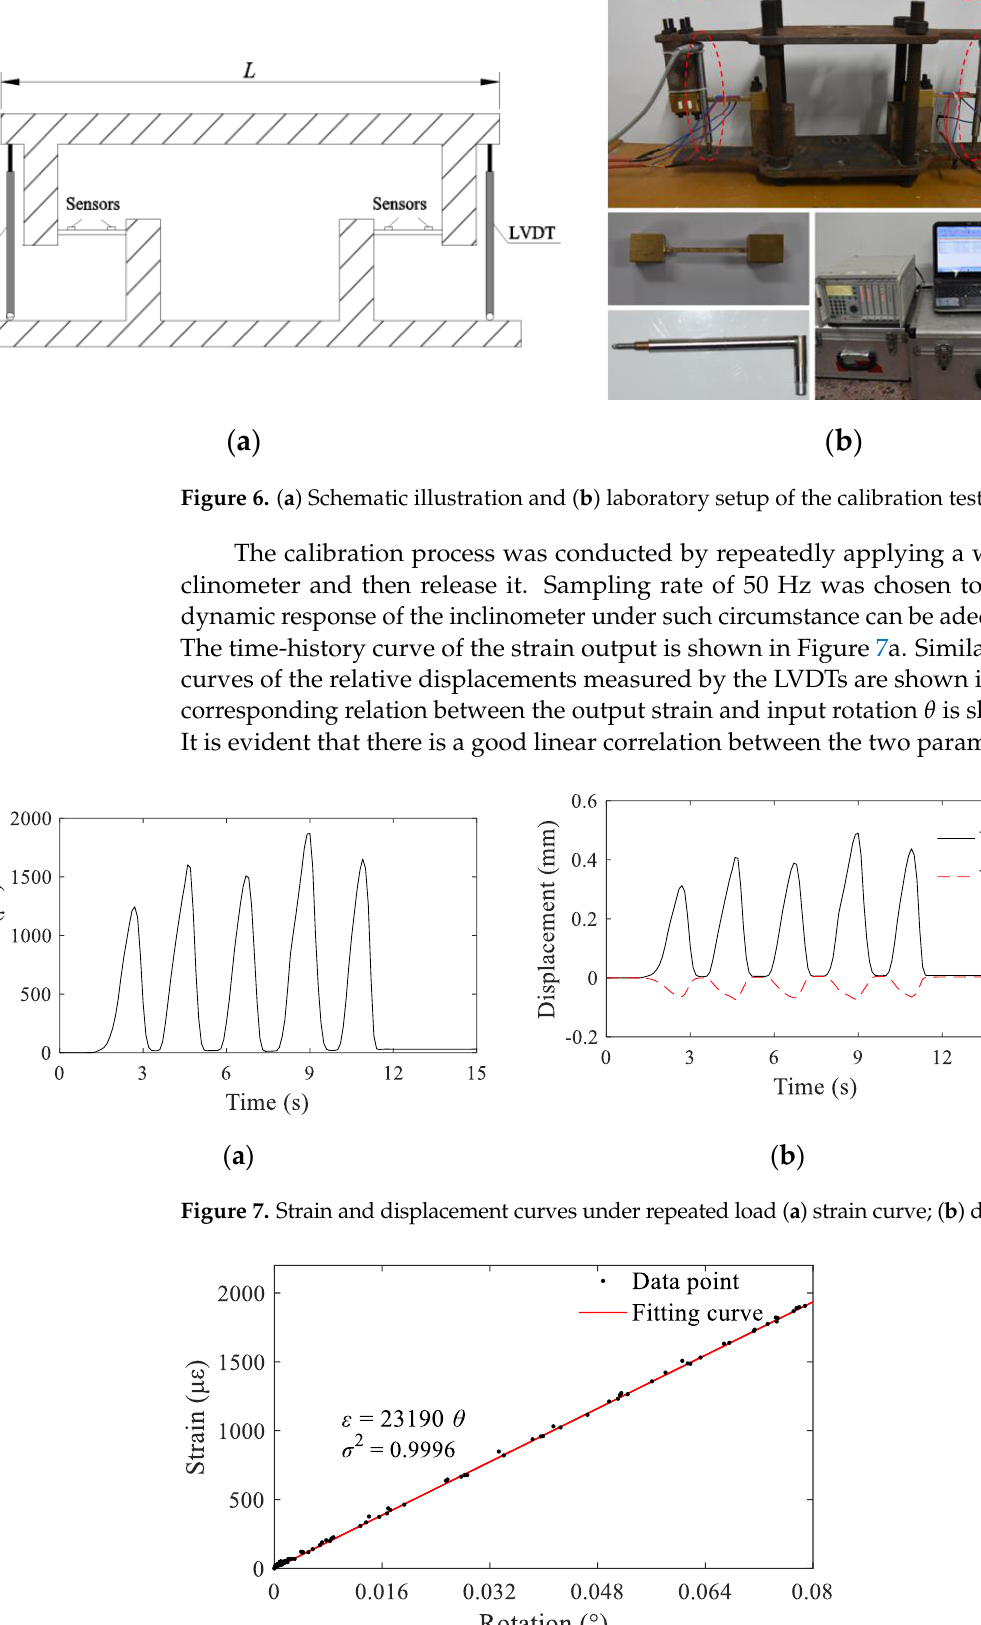
Figure 8. Rotation-strain curve.